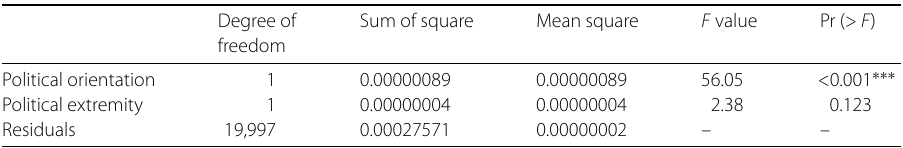
Table 17 Multi-group mean comparisons of ingroup loyalty using Tukey’s HSD test Mean 95% Confidence interval Adjusted difference P-valueLower Upper bound bound lwe-lw 0.0001 –0.0004 0.0005 0.9834 rw-lw 0.0005 0.0001 0.001 0.0052 ∗ rwe-lw –0.0001 –0.0005 0.0004 0.9854 rw-lwe 0.0005 0.0001 0.0009 0.0195 rwe-lwe –0.0001 –0.0006 0.0003 0.8949 rwe-rw –0.0006 –0.001 –0.0002 0.0022 ∗